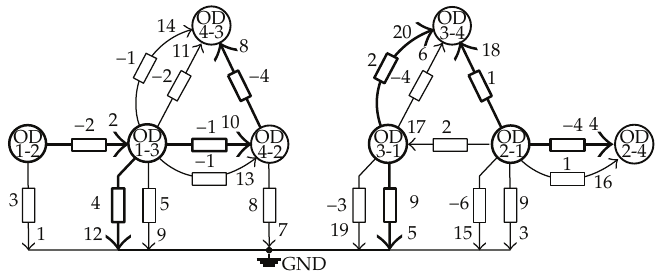
Figure 7: Nguyen-Dupuis case 1: entire associated network and measured spanning tree.